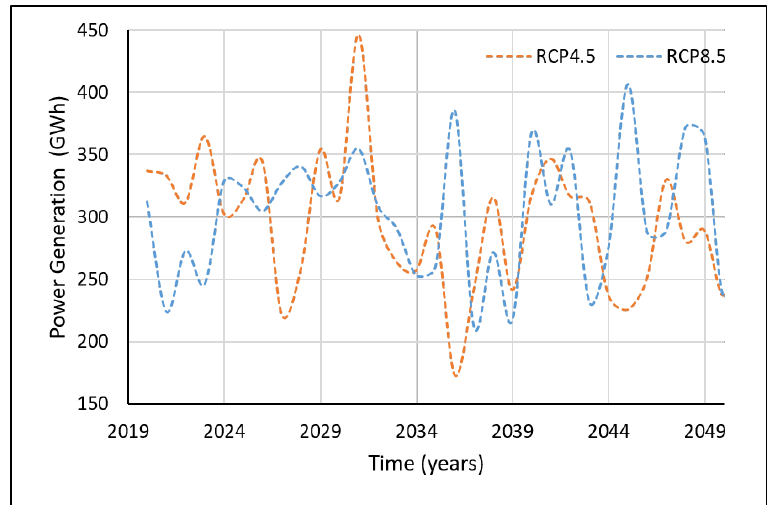
Figure 9. Hydropower predictions from Khaniya et al. (2020)